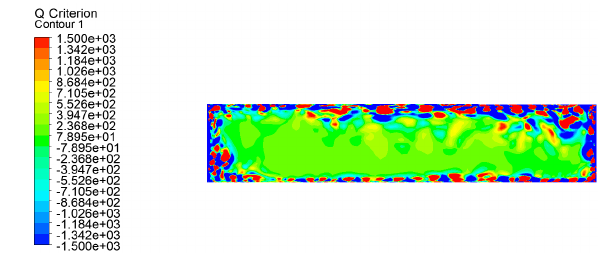
Fig. 5. Radial section, Q-criterion: LES